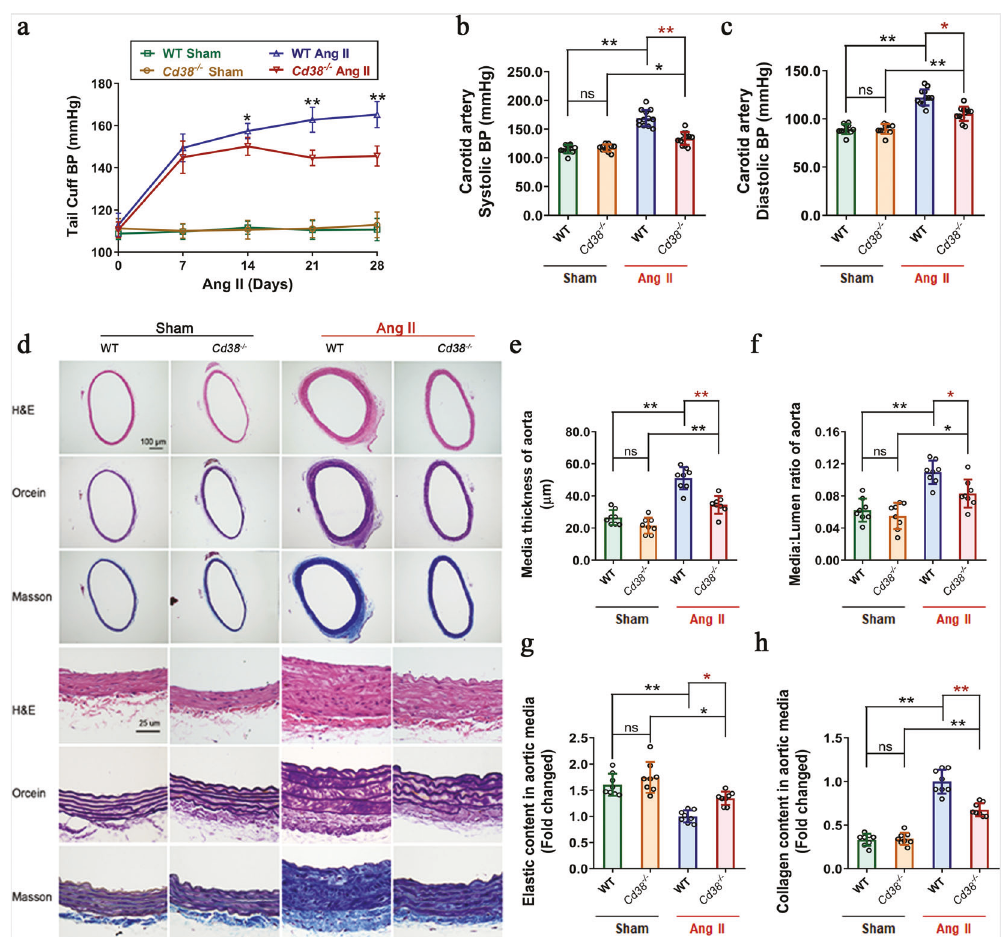
Fig. 1 CD38 de fi ciency alleviated Ang II infusion-induced hypertension and vascular remodeling. a Caudal artery blood pressures were detected in Cd38 − / − and WT mice every 7 days after Ang II or saline infusion ( n ≥ 10, two-way ANOVA, * p < 0.05, ** p < 0.01). b , c The systolic ( b ) and diastolic ( c ) blood pressures of the carotid artery were detected in Cd38 − / − and WT mice 4 weeks after Ang II or saline infusion. ( n ≥ 10, one-way ANOVA, * p < 0.05, ** p < 0.01). d Vascular remodeling was analyzed in thoracic aorta sections obtained from WT and Cd38 − / − mice with or without Ang II stimulation. Representative images of vessel sections stained with H&E, Orcein staining (the dark reddish-brown area represented elastin), and Masson trichrome blue staining (blue represents collagen deposition). e – h Medium thickness ( e ) and median-to- lum e n ratio ( f ) of the aortas were calculated on the basis of the H&E staining, and the density of stained elastin ( g ) and collagen ( h ) in the aortic smooth muscle wall were quantitatively analyzed by Orcein staining and Masson trichrome blue staining, respectively ( n = 8, one-way ANOVA, * p < 0.05, ** p <